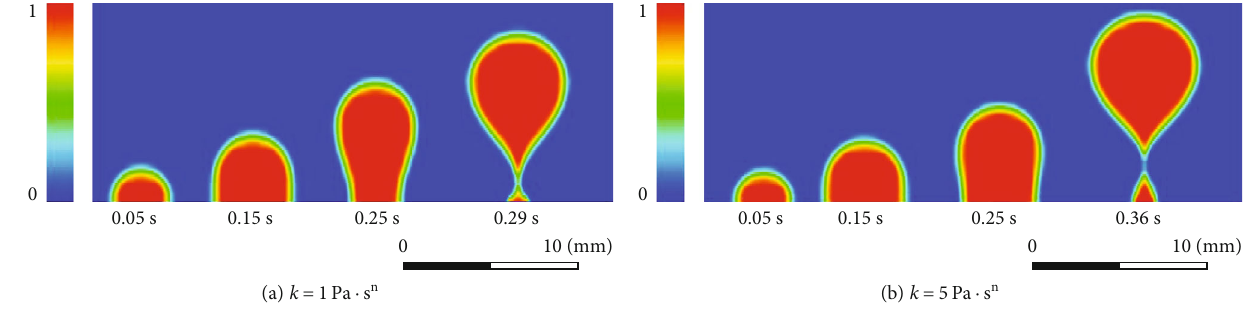
Figure 9: Bubble formation and escape processes in liquids with di ff erent k .